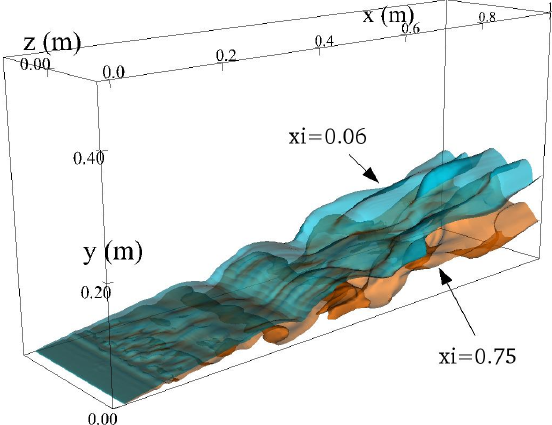
Figure 20. The iso-surfaces of the mixture fraction obtained by using coarser grid.